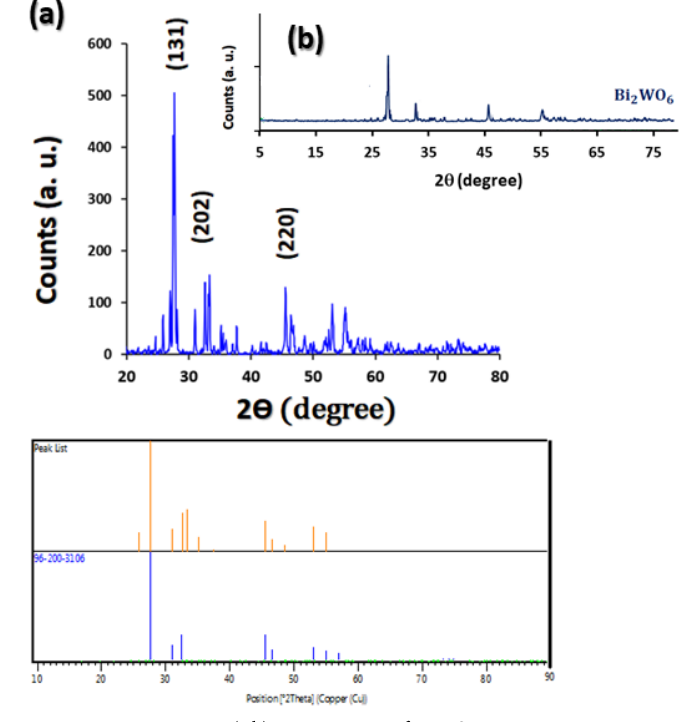
Table 1. XRD parameters of the synthesized sample